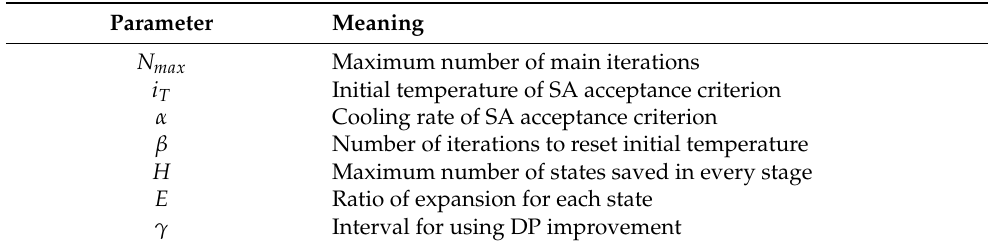
Table 3. Parameters used in the algorithm.